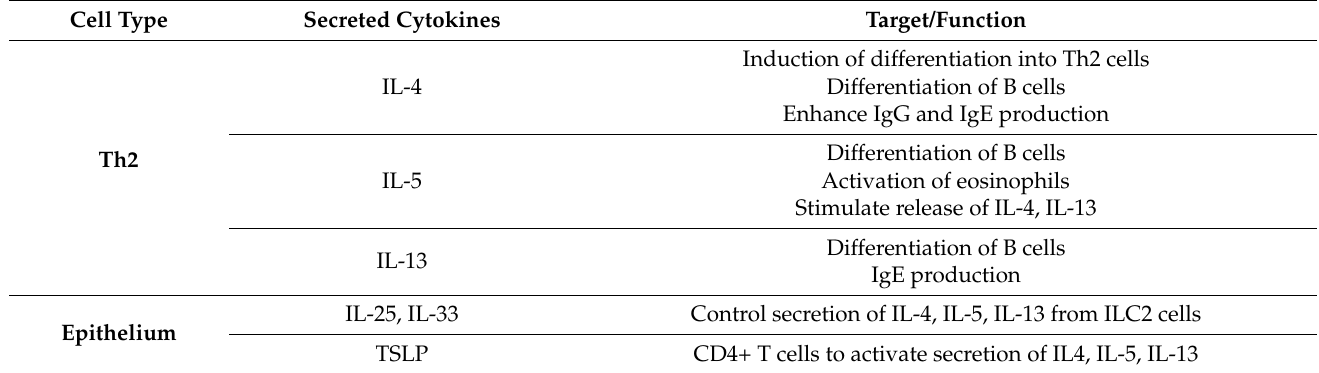
Table 1. A summary of secretory cells, cytokines, and targets/function. Adapted from Barnes 2017 [13]. Cell